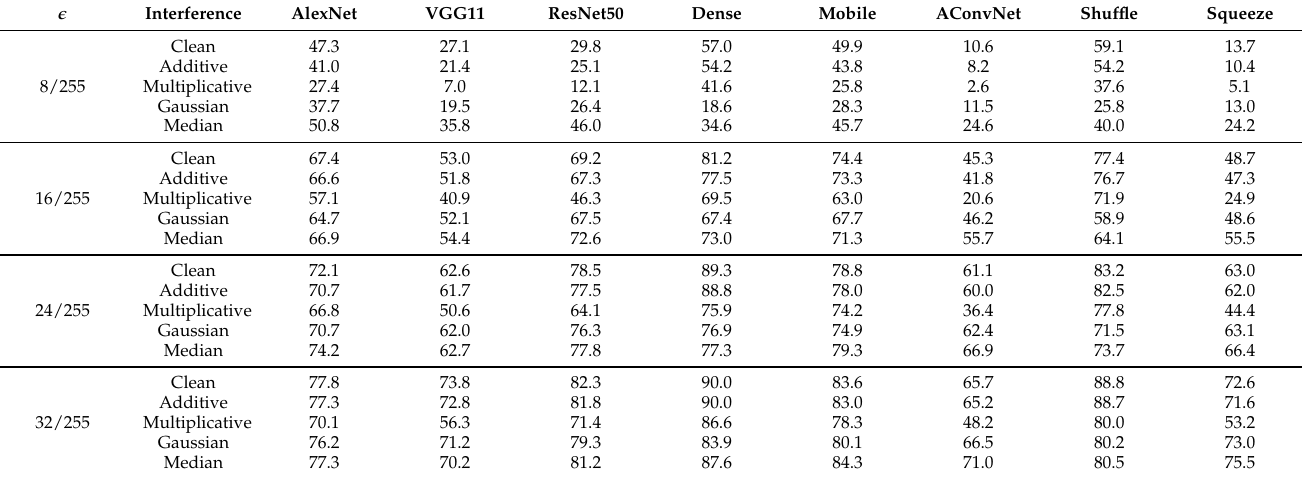
Table 5. Fooling ratio (%) against various perturbations. The additive noise is white noise with a deviation of 10 − 2 , the multiplicative noise is truncated exponential noise with a tail of 2, the deviation of Gaussian filtering is 1. Kernel size of the filters is 7 × 7. The results of random noise are averaged on 10 runs. Results of DF-UAP and GD-UAP can be found in Tables A3 and